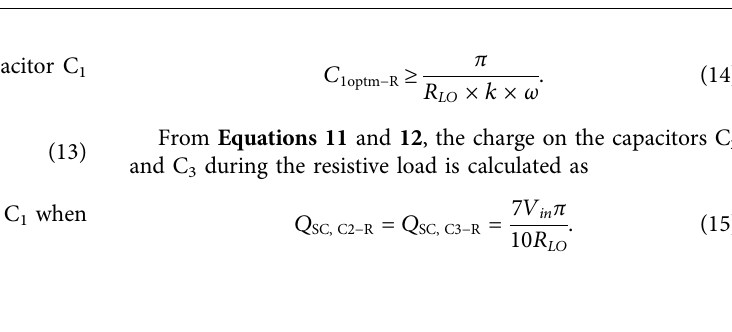
FIGURE 1 | Topology and its modes of operation. (A) Proposed CG-9L topology, (B) V o = 0.5V in , (C) V o = V in , (D) V o = 1.5V in , (E) V o = 2V in , (F) V o = 0, (G) V o = − 0.5V − V − 1.5V − 2V in , (H) V o = in , (I) V o = in , and (J) V o = in